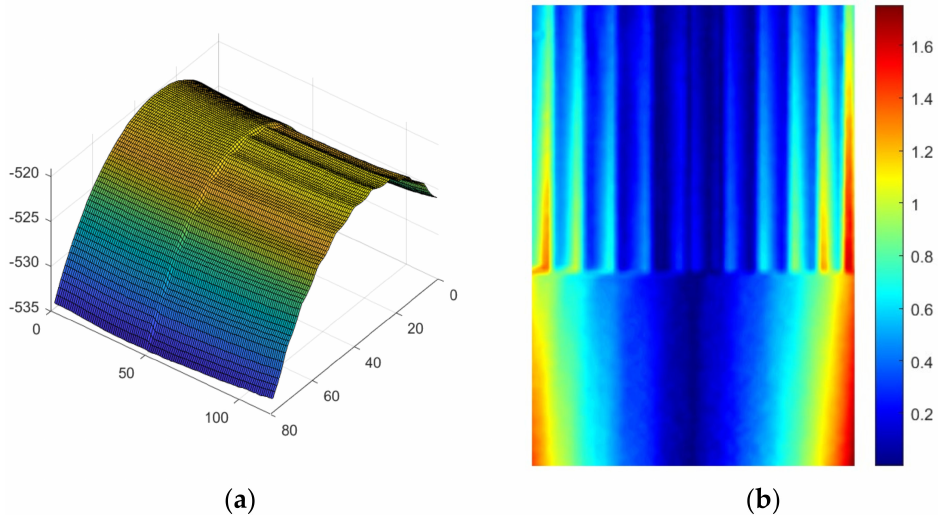
Figure 5. Experimental results: ( a ) 3D reconstruction result of the surface of the object under test; ( b ) 3D displacement measurement result of the rigid body on the surface of the object under